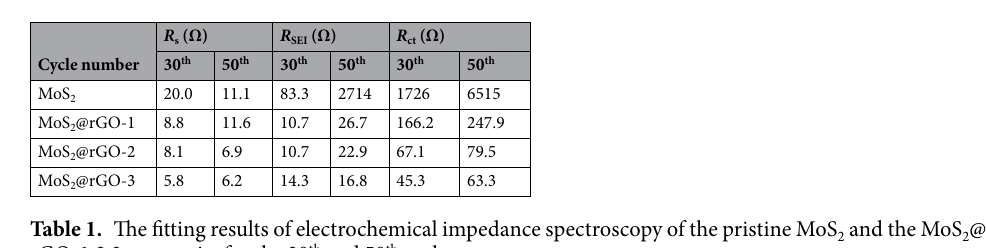
Table 1. The fitting results of electrochemical impedance spectroscopy of the pristine MoS 2 and the MoS 2 @ rGO-1,2,3 composite for the 30 th and 50 th